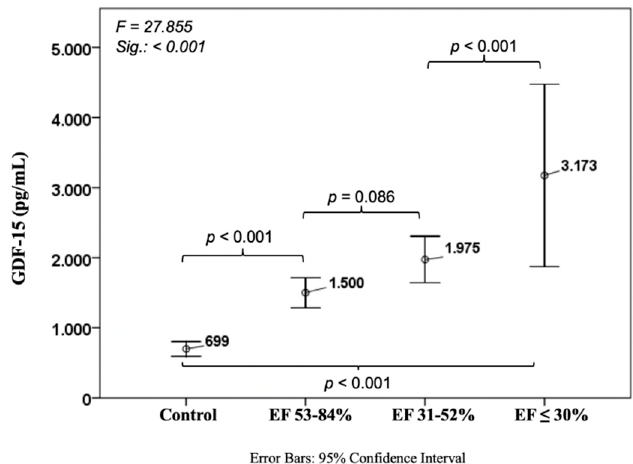
Figure 2. Course of growth differentiation factor 15 in ischemic heart disease. GDF-15: Growth differentiation factor 15.